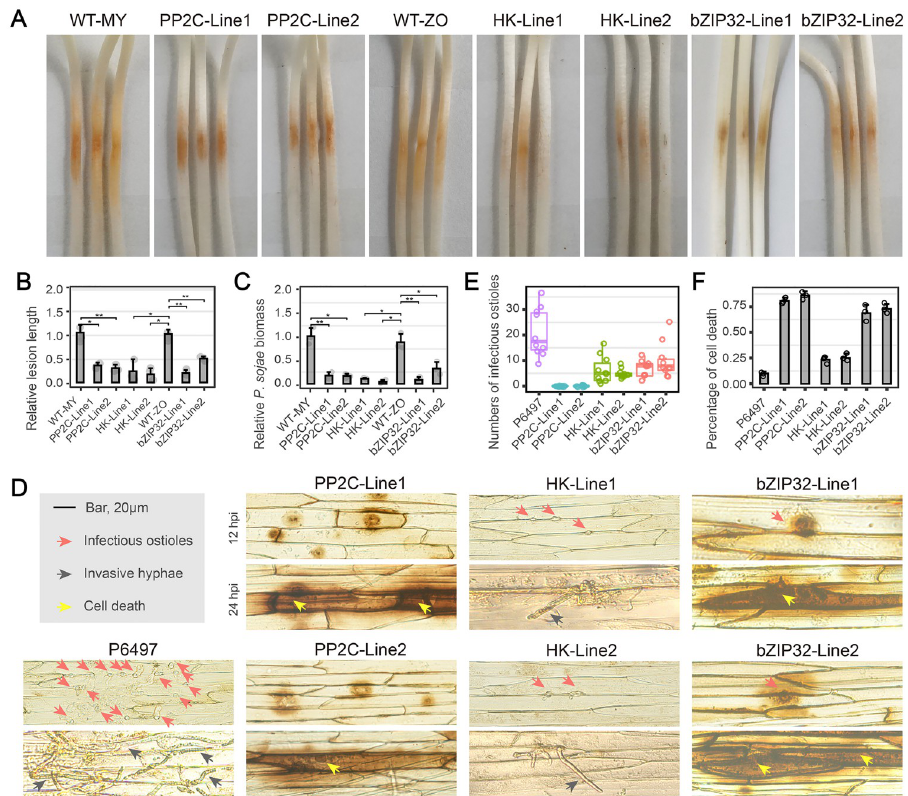
Fig 6. Asexual development-linked genes function in virulence. (A) Virulence assays of mycelium plugs from wild- type (WT-MY), PP2C-knockout mutants (PP2C-Line1 and PP2C-Line2) or of zoospores from the wild-type (WT-ZO), HK-knockout mutants (HK-Line1 and HK-Line2), and bZIP32-knockout mutants (bZIP32-Line1 and bZIP32-Line2). Etiolated hypocotyls were inoculated with same size of mycelium plugs or equal numbers of zoospores (100 zoospores/5–10 μ L) and incubated at 25˚C in the dark. (B and C) Relative lesion length (B) and pathogen biomass (C) in inoculated hypocotyls expressed as the ratio of the amounts of Phytophthora sojae DNA to soybean DNA detected at 48 hpi, with the P . sojae /soybean ratio set at 1. All experiments were repeated three times with similar results. ** Significant difference at p < 0 . 01 . * Significant difference at p < 0 . 05 . (D) Microscopic observations of infectious ostioles and invasive hyphae in epidermis of soybean hypocotyls at 12 hpi and 24 hpi. DAB staining was performed on the epidermis of seedling hypocotyls. Red arrowheads, infectious ostioles; gray arrowheads, invasive hyphae; bright yellow arrowheads, cell death. Bar, 20 μ m. (E) Numbers of infectious ostioles in epidermal cells of soybean hypocotyls at 12 hpi. (F) Percentage of cell death response of inoculated soybean hypocotyls of wild-type (P6497), PP2C-knockout mutants (PP2C-Line1 and PP2C-Line2) and HK-knockout mutants (HK-Line1 and HK-Line2), and bZIP32-knockout mutants (bZIP32-Line1 and bZIP32-Line2) at 24 hpi. In each sample 50 invaded epidermal cells were examined and the experiments were repeated three